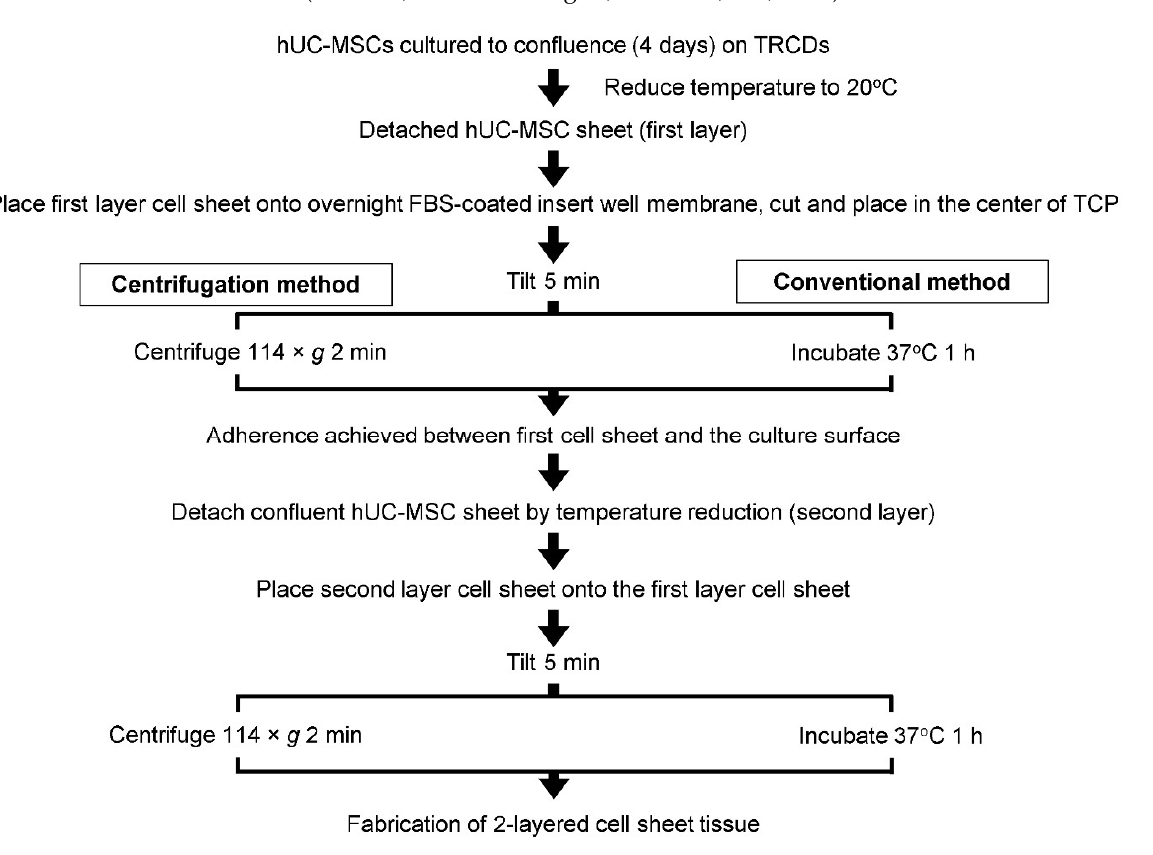
Figure 1. Flow chart illustrating the MSC sheet layering protocol with centrifugation (centrifugation method) and without centrifugation (conventional method).